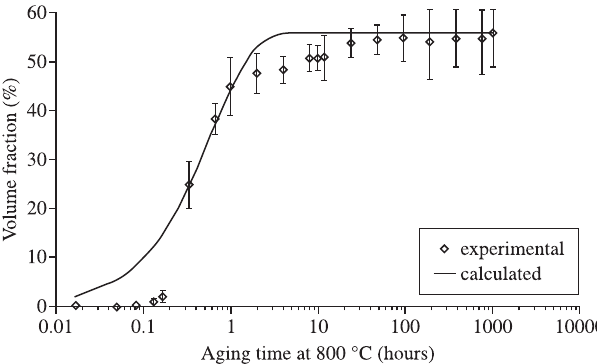
Figure 15. Experimental and calculated sigma phase content (vol. %) as a function of aging time at 800 °C.